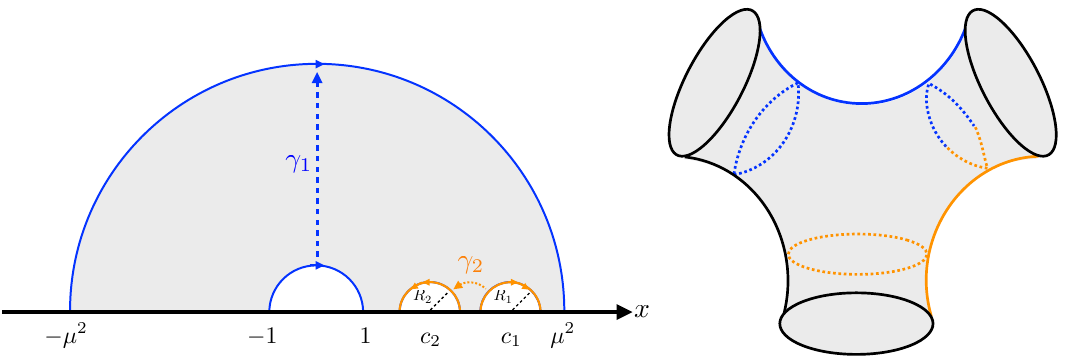
Figure 3 . Three-boundary wormhole obtained from the identification (2.8). Left: gray shaded region is a fundamental domain of the identification by { γ 1 , γ 2 } ∈ Γ . Colored circles with arrows will be seen as identical to each other, including their orientation. Right: the resulting three boundary-wormhole. A blue (An orange) circle will be calculated from tr γ 1 ( tr γ 2 ). A half blue and half orange circle will be obtained via tr( γ 1 γ 2 )